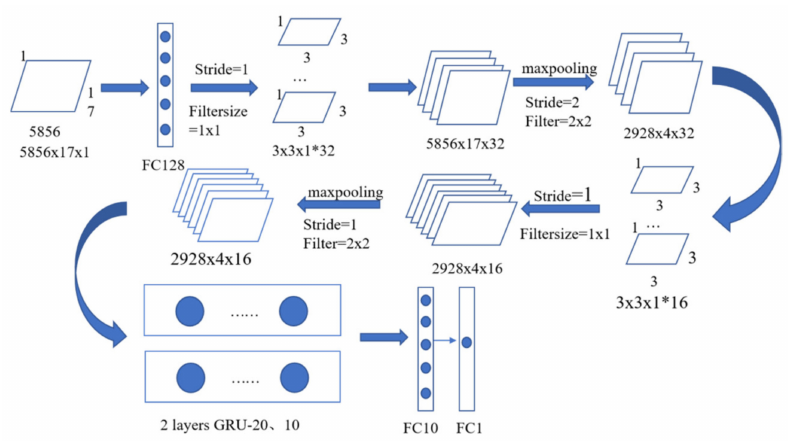
Figure 4. Flowchart of the